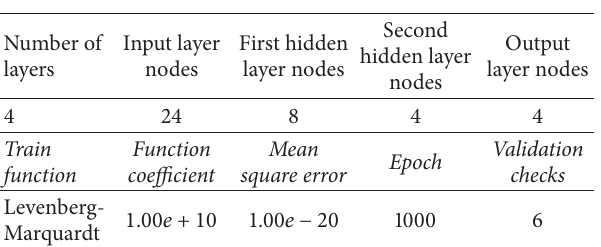
Table 4: Parameters of